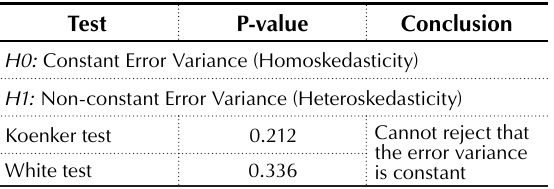
Table 5. Results of Koenker test and White test